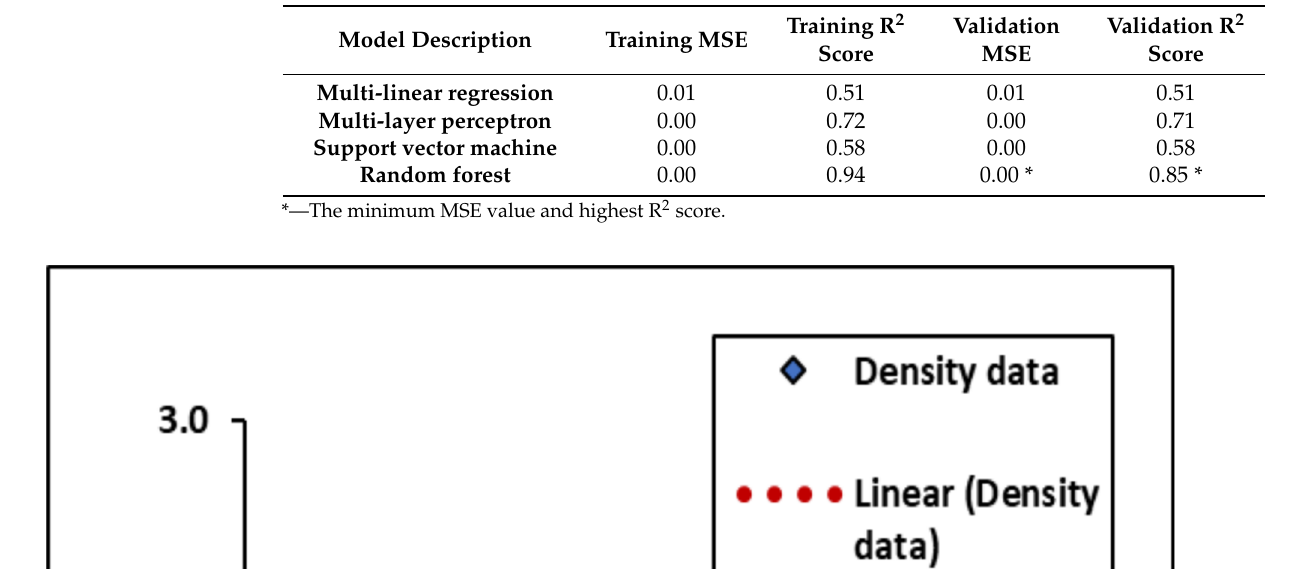
Table 6. Model comparison for synthetic RHOB prediction with four supervised ML models. RF model reached the least MSE and highest R 2 score on the validation data set highlighted in the table.